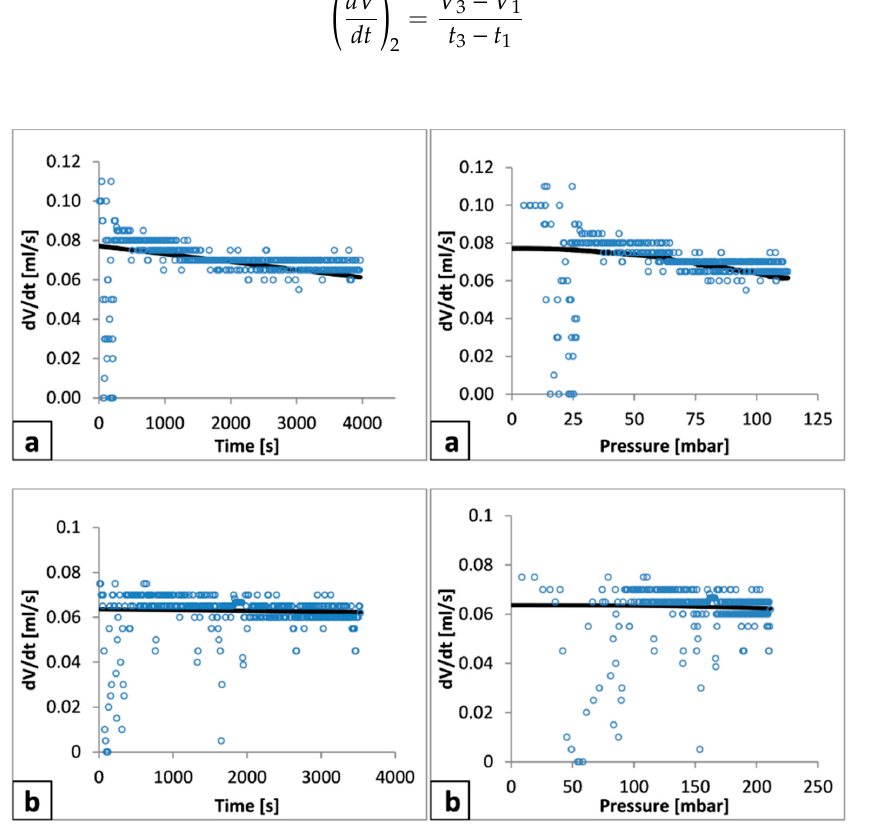
Figure 8. Filtration flow rate with time and pressure for talc using 5 rpm pump speed, ( a ) 0.01 v / v and ( b ) 0.05 v / v (2nd polynomial equation, Equation (6) ( ̶ ) and central difference ( ○ ) Equation (8)).